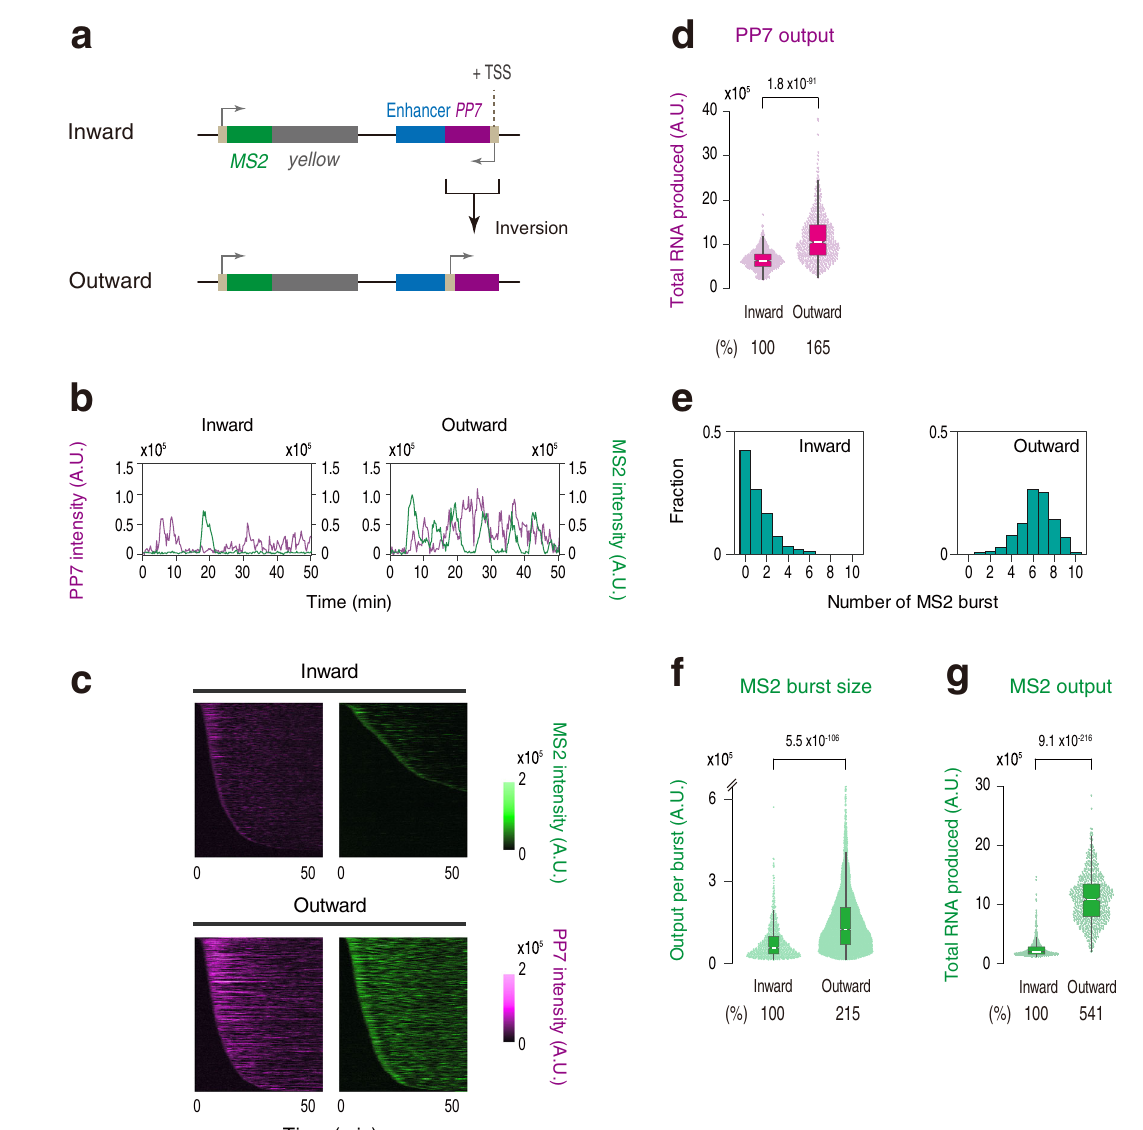
Fig. 4 | Enhancer self-transcription is required for target gene attenuation. a PP7 transcription unit at the enhancer region was inverted to drive non-coding transcription in an outward orientation relative to the sna shadow enhancer. b Representativetrajectoriesoftranscriptionactivitiesofthereporterlocusdriving PP7 transcription in an inward (left) or an outward orientation (right). c MS2 and PP7 trajectories for all the analyzed nuclei. Each row represents the MS2 or PP7 trajectory for a single nucleus. A total of 739 and 666 ventral-most nuclei, respec- tively, were analyzed from three independent embryos for the reporter locus driving PP7 transcription in an inward (top) or an outward orientation (bottom). Nuclei were ordered by the onset of MS2 or PP7 transcription in nc14, separately. The same number of nuclei were analyzed hereafter. d Boxplot showing the dis- tributionofthetotaloutputofPP7transcription.Theboxindicatesthelower(25%) and upper (75%) quantile and thewhite line indicates the median. Whiskers extend